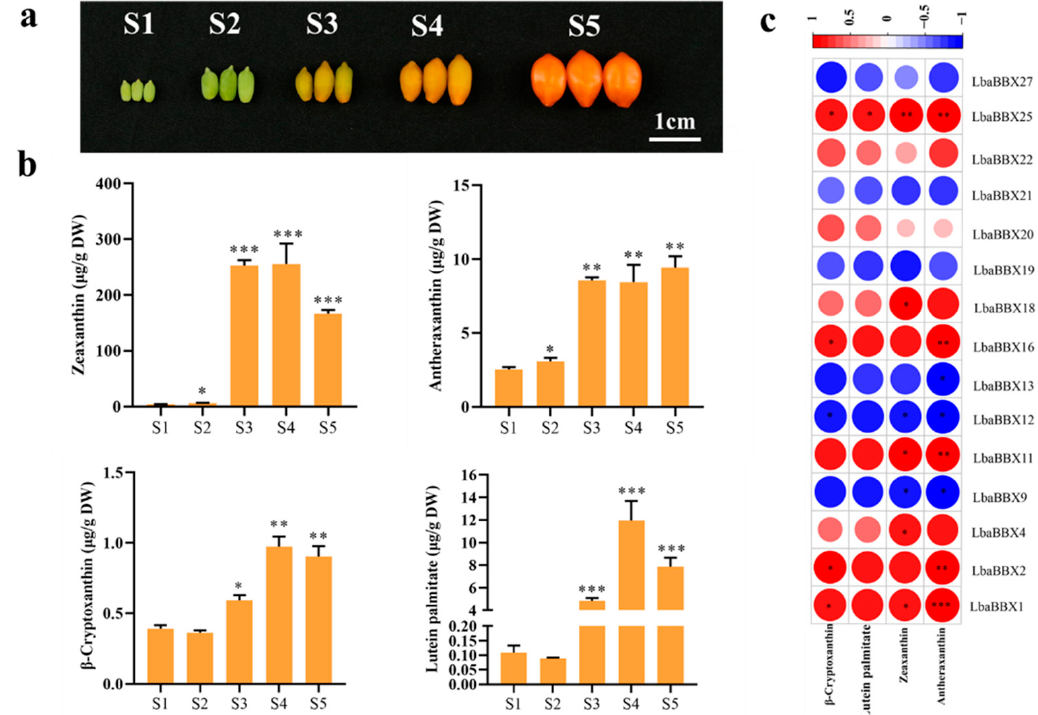
Figure 7. Identification LbaBBX genes related to carotenoid biosynthesis. ( a ) Fruits of Lycium barbarum var. auranticarpum at different stages of development. S1, S2, S3, S4, and S5 period represent 12, 19, 25, 30, and 37 days after full bloom (DAF), respectively. Scale bars represent 1 cm. ( b ) Trends in carotenoids (zeaxanthin, antheraxanthin, β –cryptoxanthin and lutein palmitate) at five develop- mental stages. The data contain the averages and standard deviations of three individual replicates. Asterisks indicate a significant difference (* p < 0.05, ** p < 0.01, *** p < 0.001) compared with S1 at the different time points during development. ( c ) Correlation analysis was constructed using the expression levels of LbaBBX genes and carotenoids content in five different developmental stages. The blue color means negative correlation, the red color means positive correlation. Asterisks indi- cate a significant difference (* p < 0.05, ** p < 0.01, *** p < 0.001).